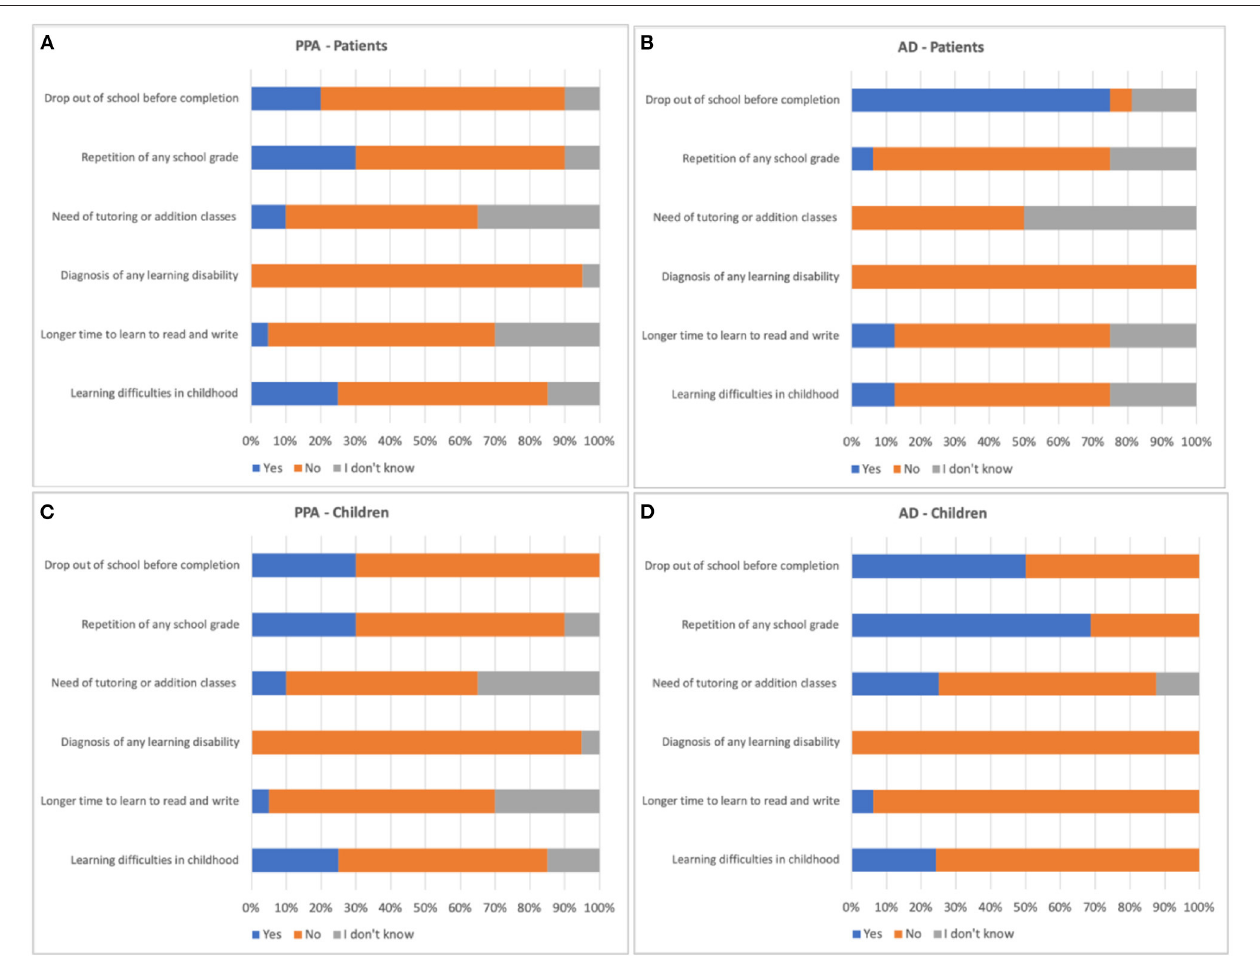
FIGURE 1 | Description of the percentage of responses in the questionnaire of learning difficulties history of the AD and PPA groups. AD, Alzheimer’s disease; PPA, primary progressive aphasia. (A) responses of PPA patients; (B) responses of AD patients; (C) responses of PPA children; (D) responses of AD children.